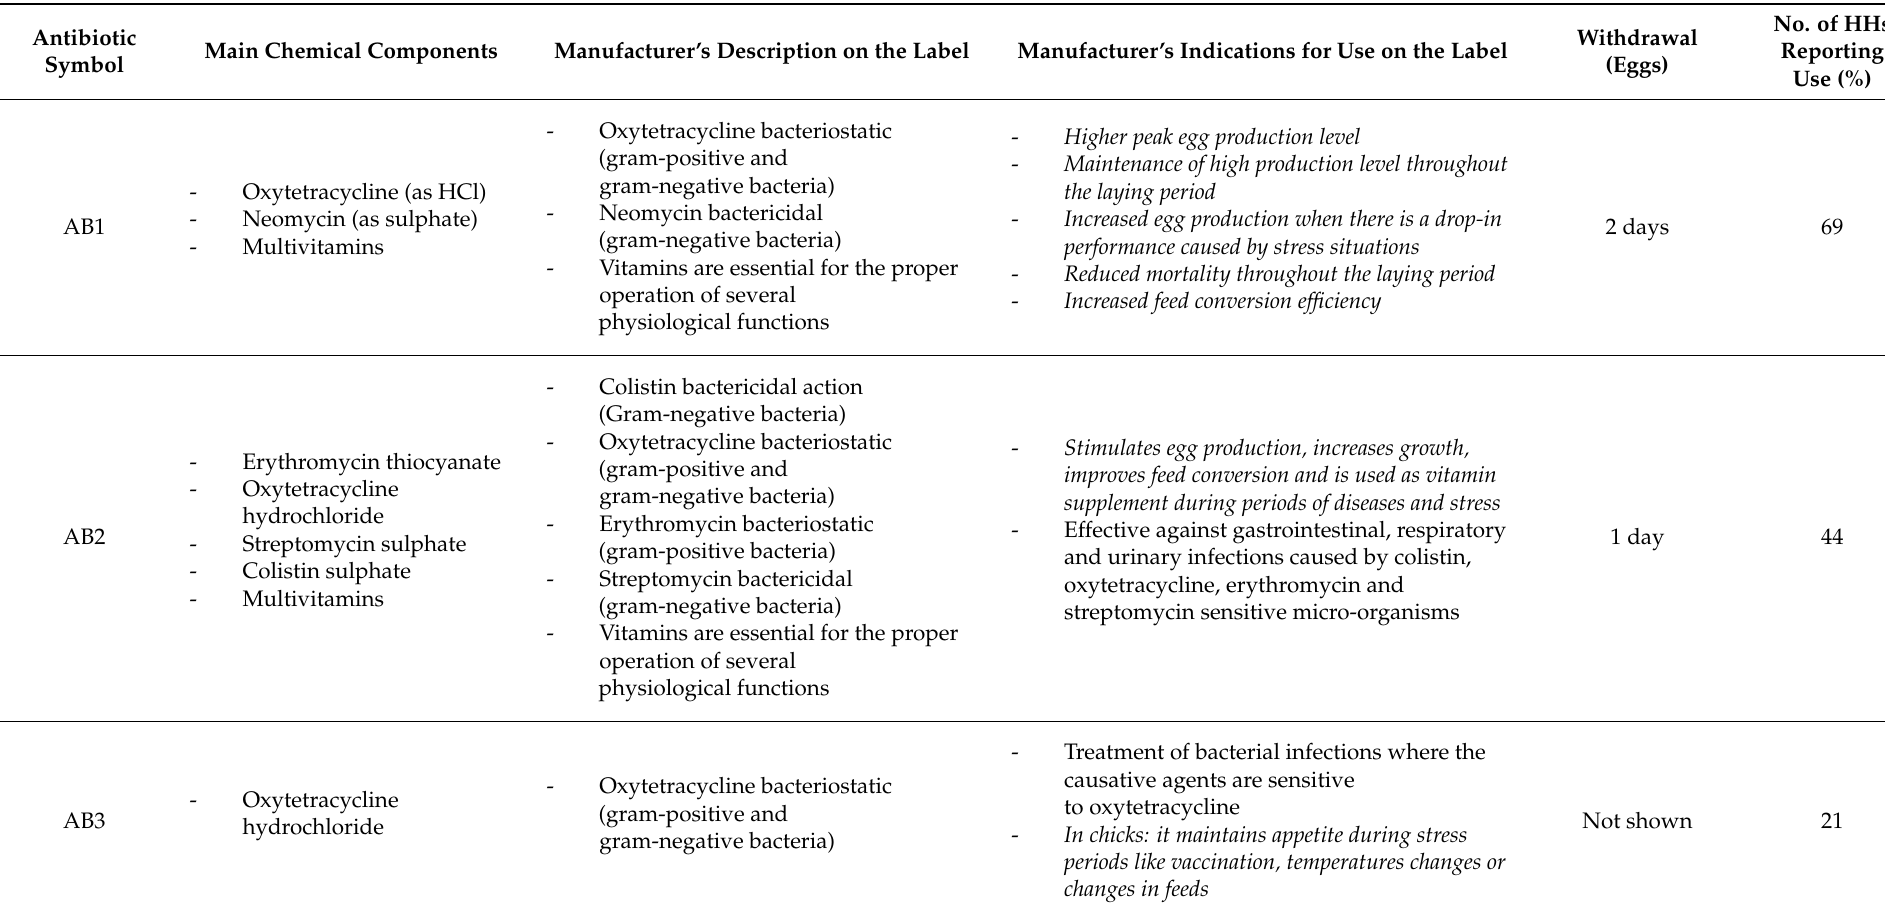
Table 1. Medicines reported as commonly used by layer farmers in Gatundu North identified via their chemical components, manufacturer’s description, manufacturer’s indications, and withdrawal periods. AB (1–7) refer to the antibiotics under investigation with actual trade names withheld. Only those reported by 10% or more of households are reported here. Note the manufacturer’s description of the medicine vs. the manufacturer’s indications for use, which may serve as the motivation for use. In bold are the manufacturers’ indications for use that are related to “use for prophylaxis”, while in italics are antibiotics used as “growth promoters” or to “promote